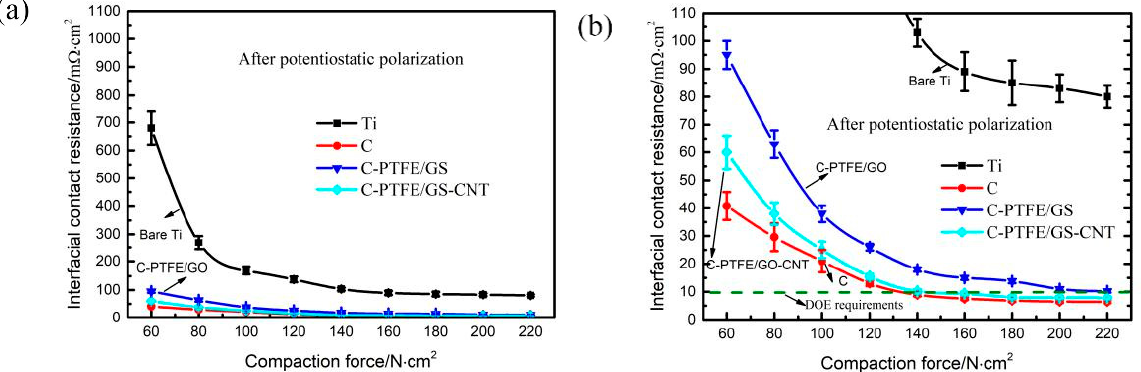
Figure 11. ICR of samples before potentiodynamic polarization with different compaction force in Figure 11 . ICR of samples before potentiodynamic polarization with different compaction force in ambient environment. ( a ) ICR value; ( b ) Enlarged figure of the ICR value within 100 m Ω · cm 2 ambient environment. ( a ) ICR value; ( b ) Enlarged figure of the ICR value within 100 m Ω ·cm 2 .